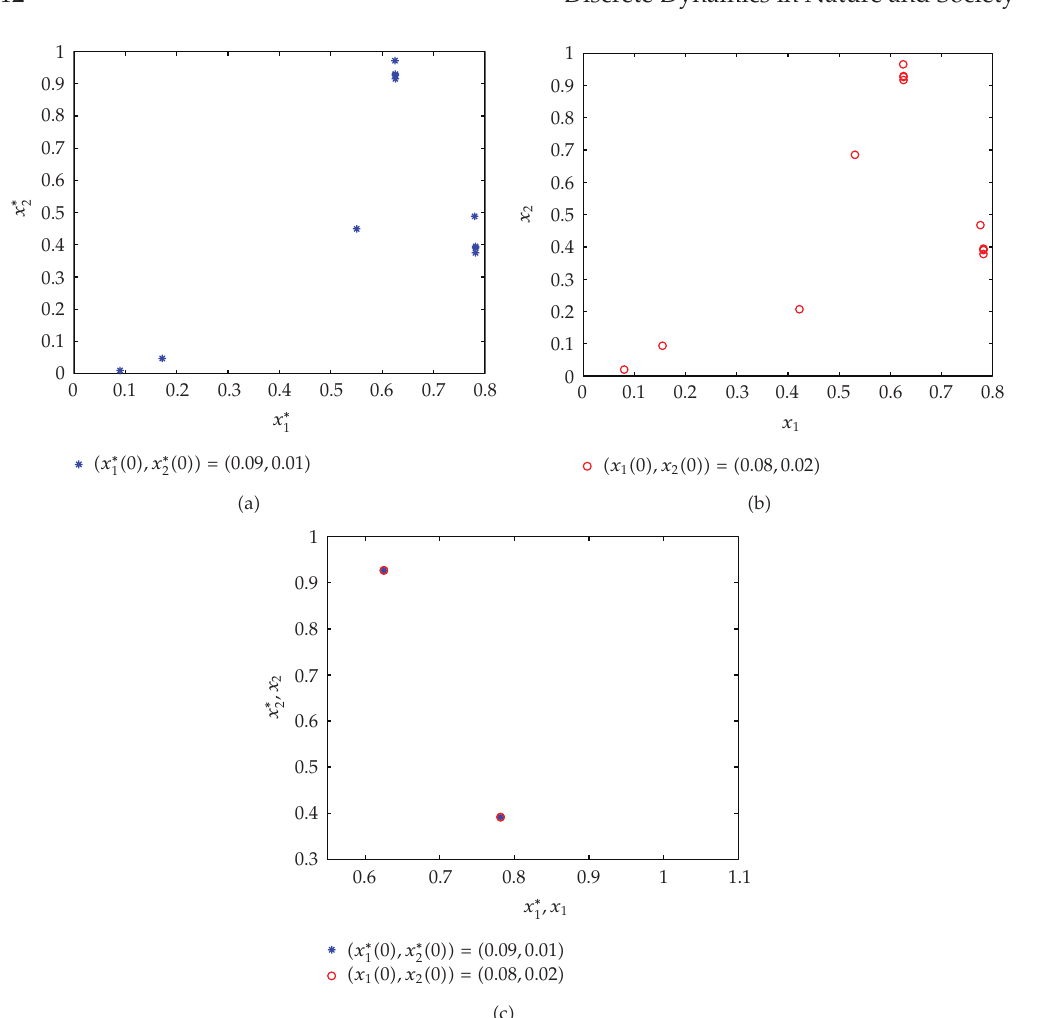
Figure 4: (cid:6) a (cid:7) Phase portrait of x ∗ and x 2 with initial value (cid:6) 0 . 08 , 0 . 02 (cid:7) for n ∈ (cid:2) 0 , 50 (cid:3) . (cid:6) c (cid:7) Phase portraits of x ∗ in the same coordinate